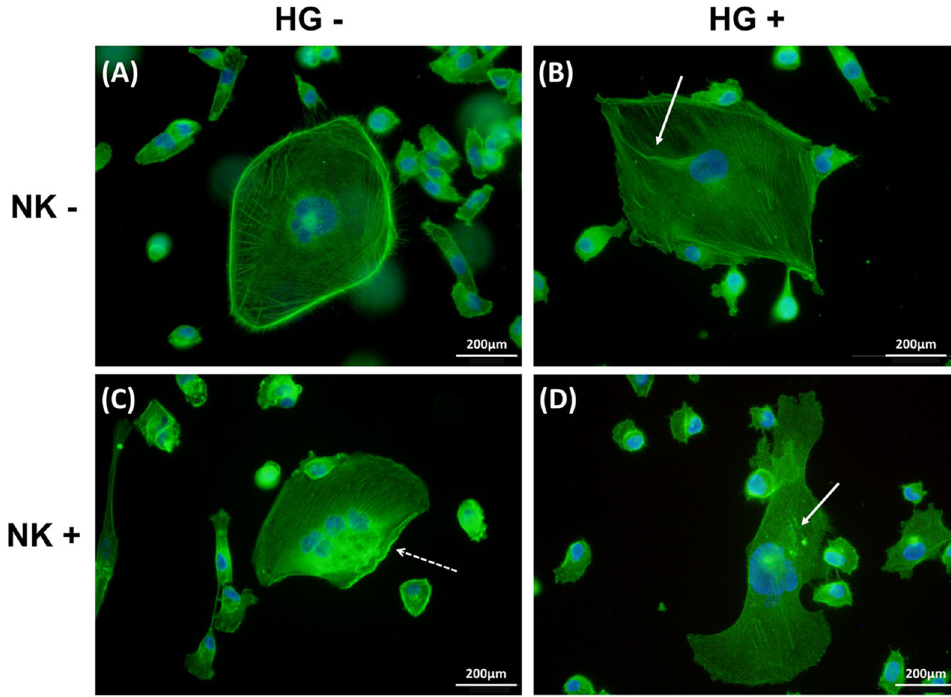
Figure 2. F-actin immunofluorescence in MDA-MB-231. Immunofluorescence images of F-actin with AlexaFluor 488 conjugated Phalloidin. Nucleus is counterstained with DAPI. ( A ) control group in MDA-MB-231 without hypergravity (HG) and without NK cells; ( B ) MDA-MB-231 cells exposed to hypergravity and without NK cells; ( C ) MDA-MB-231 cells without hypergravity and with NK cells; ( D ) MDA-MB-231 exposed to both hypergravity and NK cells. Changes in the cytoskeletal structure are indicated with white solid arrow, and actin response with white dotted